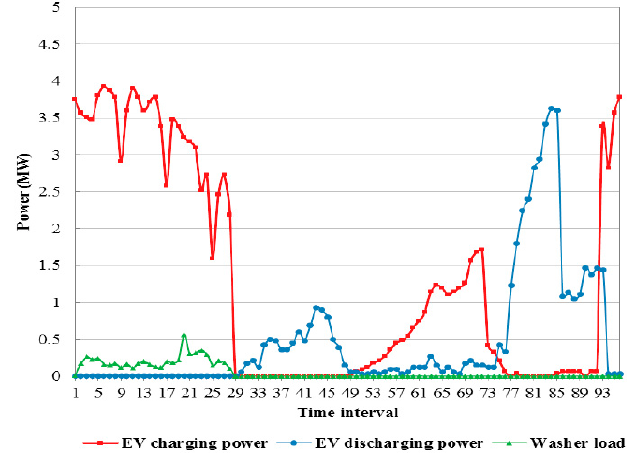
Figure 7. Shiftable electrical loads on a typical summer day.